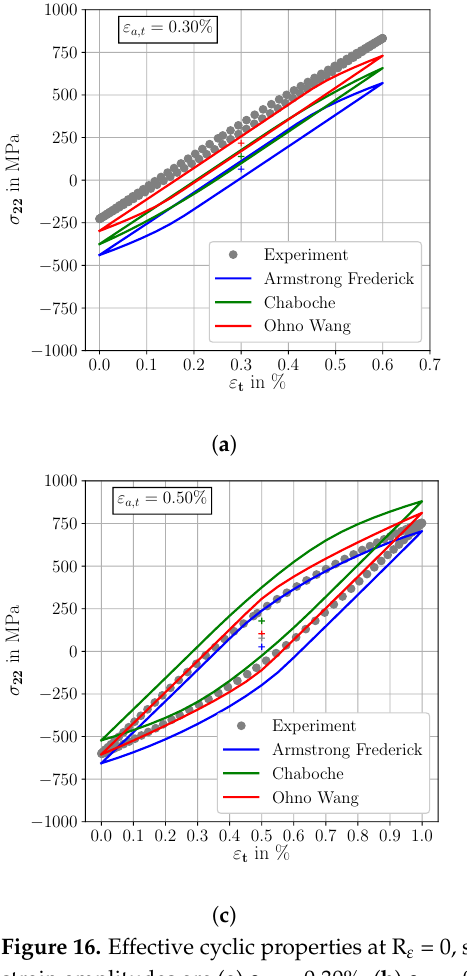
Figure 15. Plastic strain energy density characteristics at R ε = 0, for the three different KH models in cycle stable conditions and the corresponding experimental data of SAE 4150 at half lifetime.